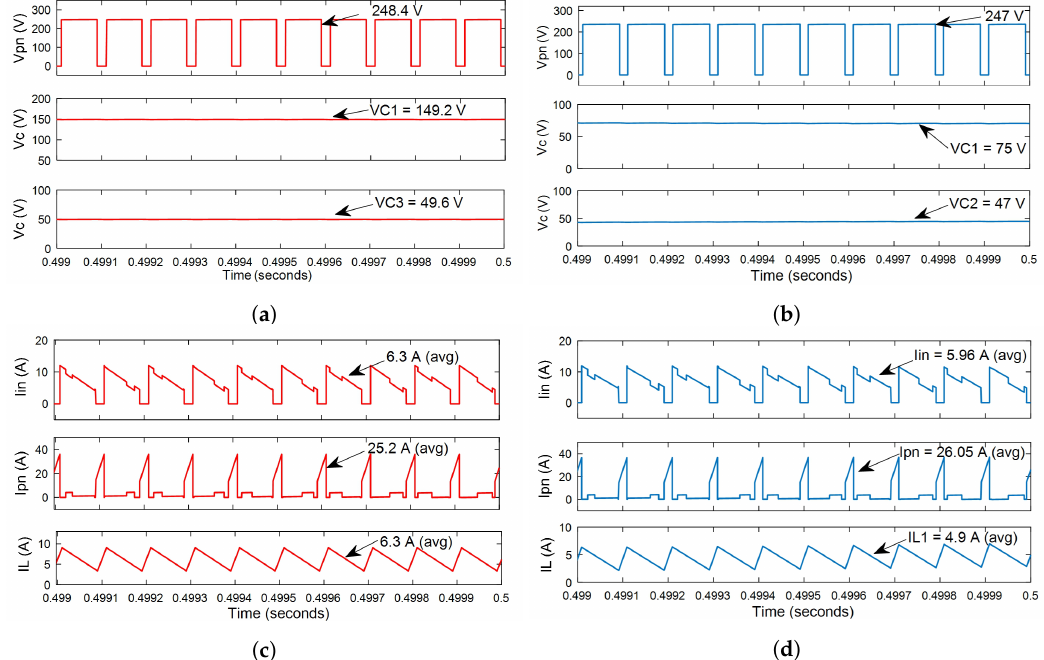
Figure 13. Simulation results (case 2): ( a ) traditional MCA-ZSI. ( b ) Proposed SL-SBZSI. From top to bottom: DC-link voltage, V pn ; capacitor voltage, V C 1 and capacitor voltage, V C 3 . Enlarge waveform: ( c ) Traditional MCA-ZSI. ( d ) Proposed SL-SBZSI. From top to bottom: input current, I in ; shoot-through current, I pn and inductor current, I L 1